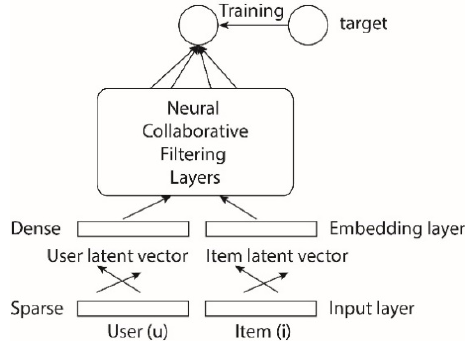
Figure 1. Neural Collaborative Filtering (NCF) architecture.